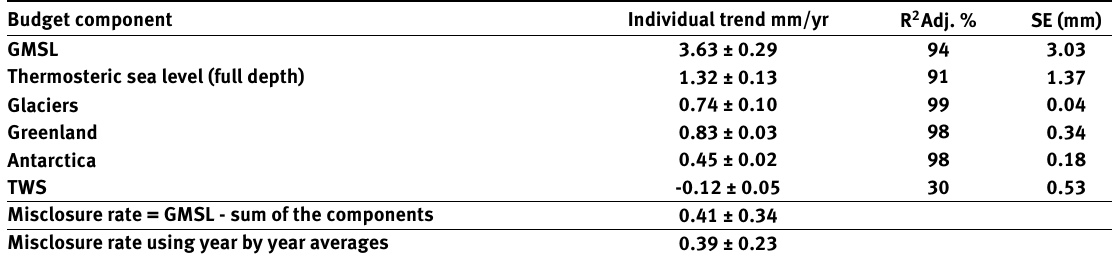
Table 1. Independently estimated trends of the GMLS budget components during 2005–2015 using yearly averaged time series by WCRP (2018).